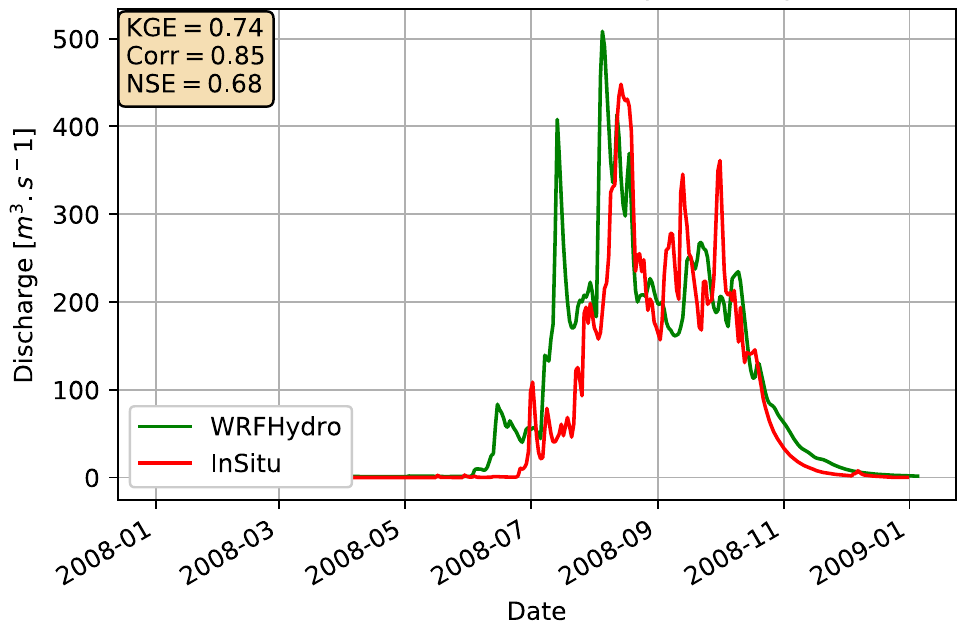
Figure 4. Evaluation of the uncoupled calibrated WRF-Hydro model over the Bétérou catchment during the calibrated year (2008).